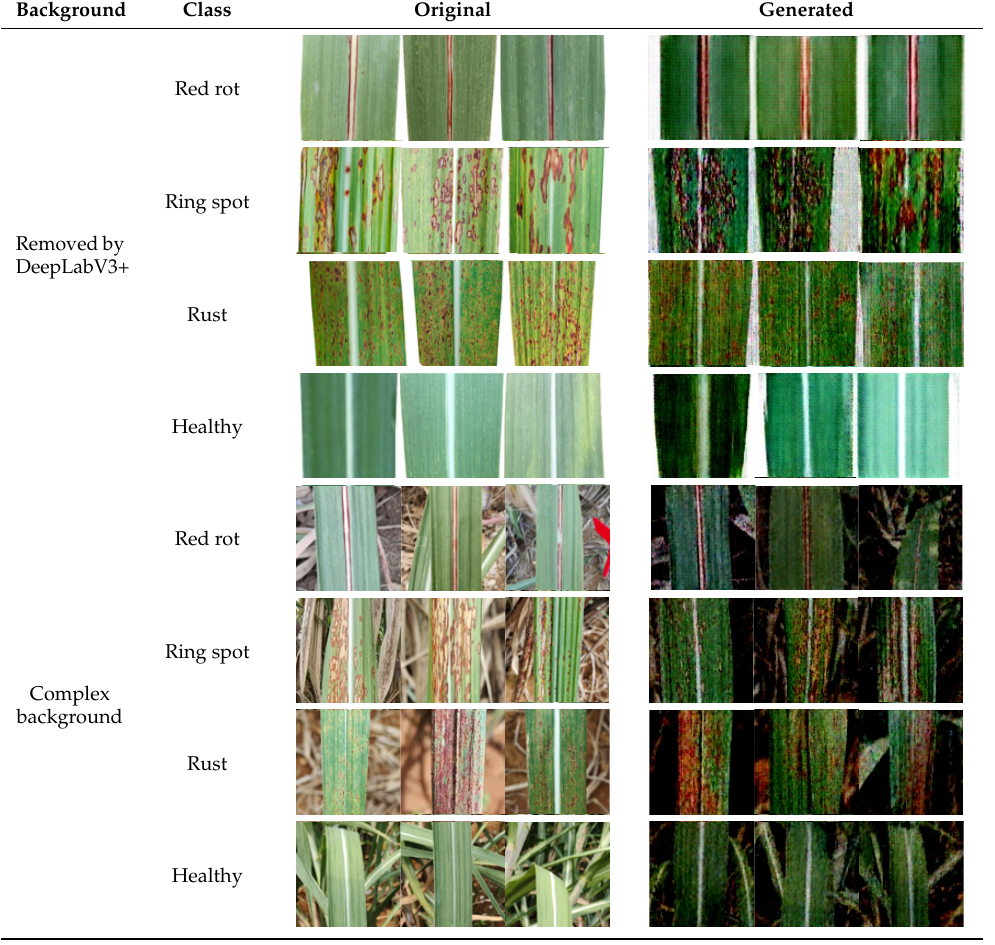
Table 6. Display of DCGAN data augmentation results.